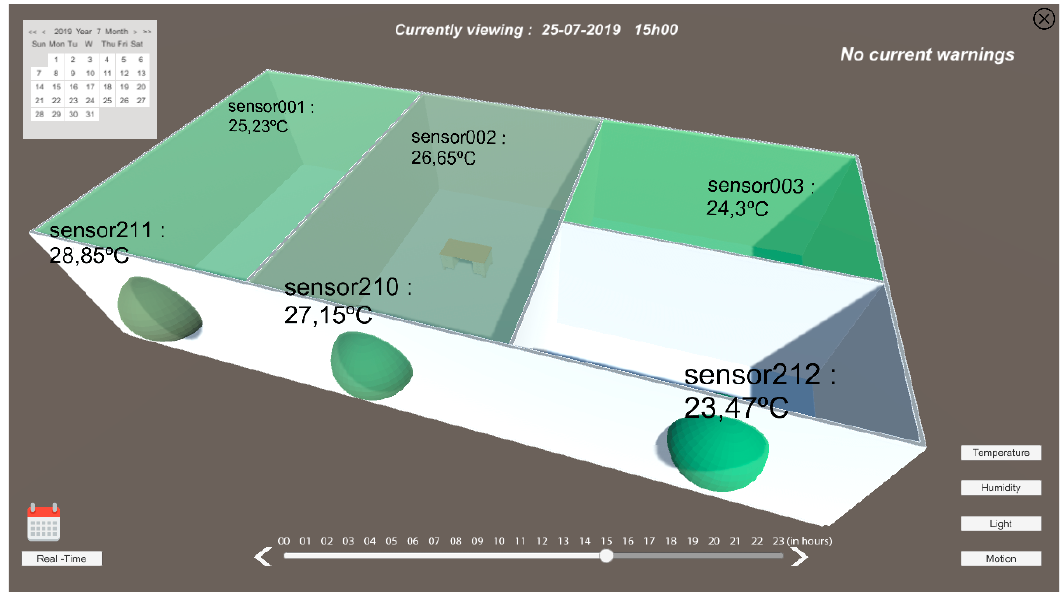
Figure 7. BIM 3D model main interface, with variable selection buttons and time scales.